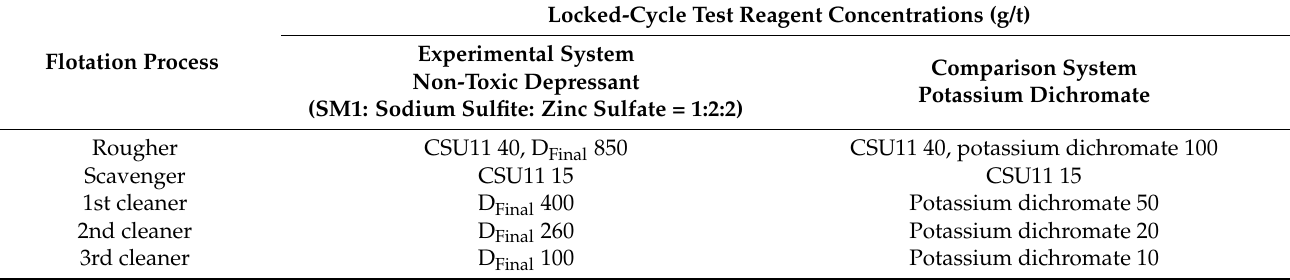
Table 4. Flotation conditions of the batch locked-cycle tests.